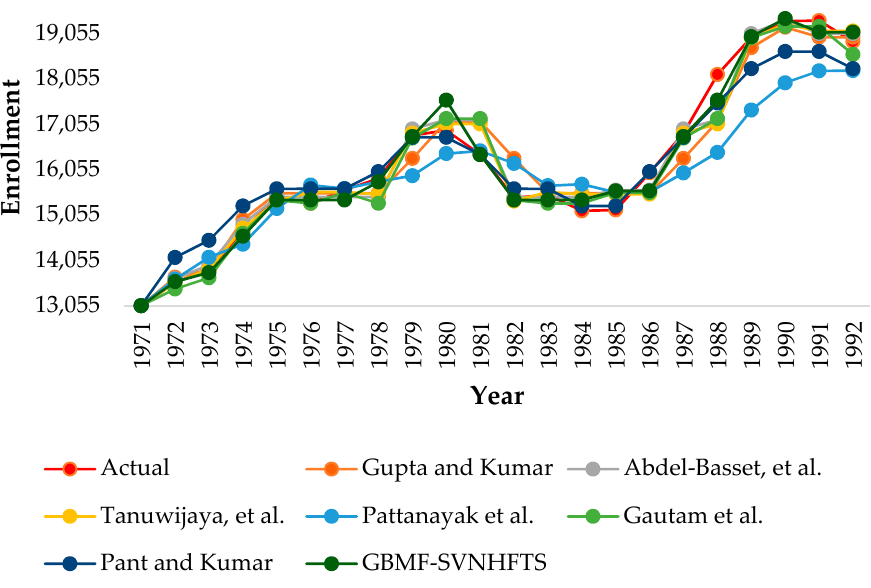
Figure 1. A graph showing the forecasted values of the historical enrollment data from the GBMF- SVNHFTS method and other FTS methods from 1971 to 1992. Table 1. A comparison of the forecasted results of the other FTS methods with the proposed GBMF- SVNHFTS.